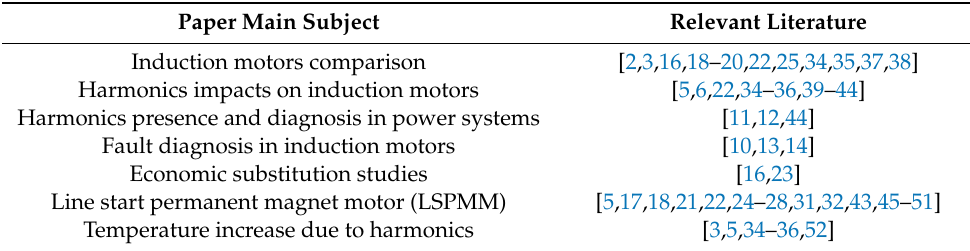
Table 1. Review of literature regarding induction motors and